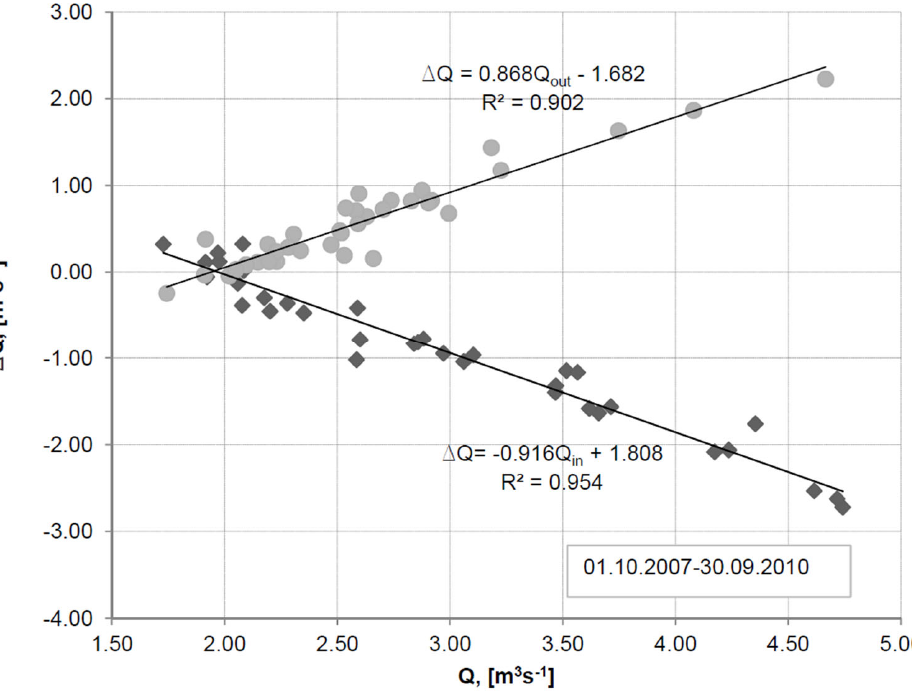
Figure 9. Scatterplots of mean monthly values obtained from the Jucar River model representing input discharge upstream vs. differential discharge between chainages 71,000 and 0 (m) (diamonds) and output discharge downstream vs. differential discharge between chainages 120,990 and 80,000 (m) (dots). Negative value for the constant term of the linear equation fit line indicates that the river is gaining, while positive values indicate that the river is losing.